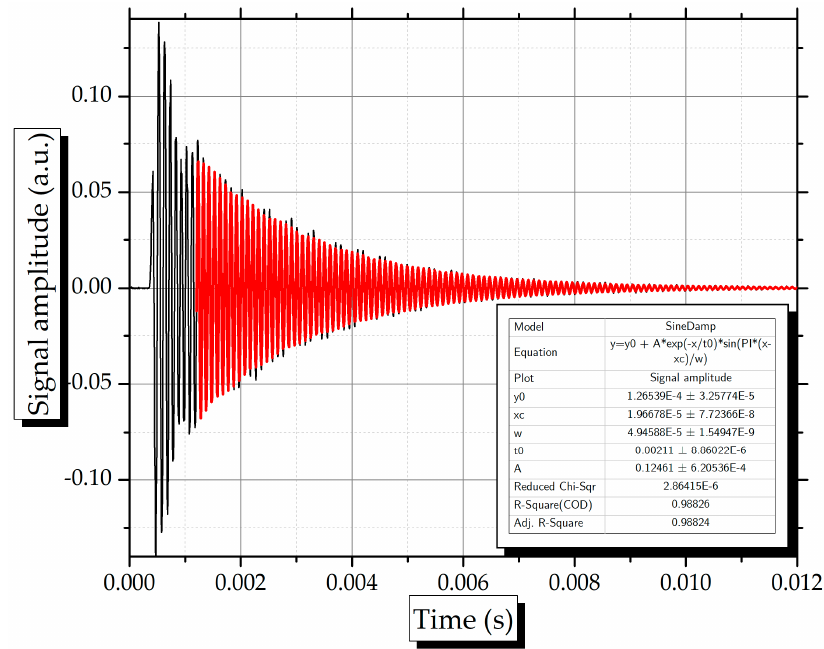
Figure 11. SineDamp function for fitting the steady-state response of the specimen.